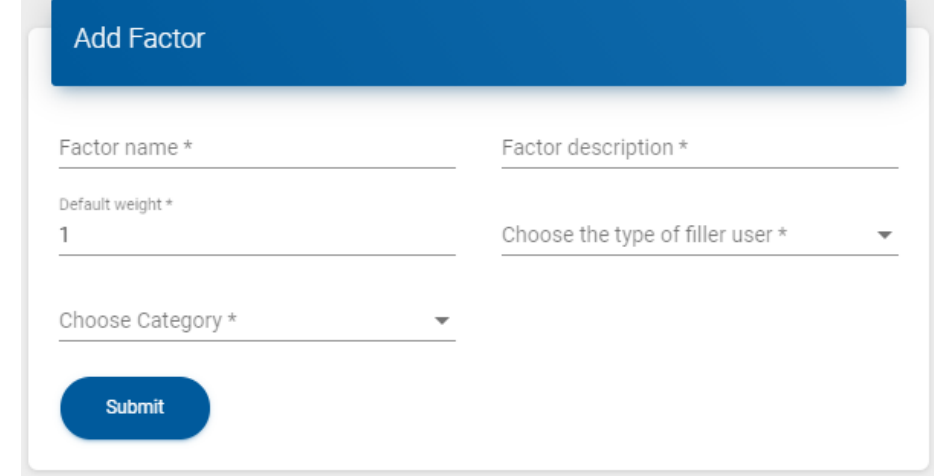
Figure 7. Factor registration.